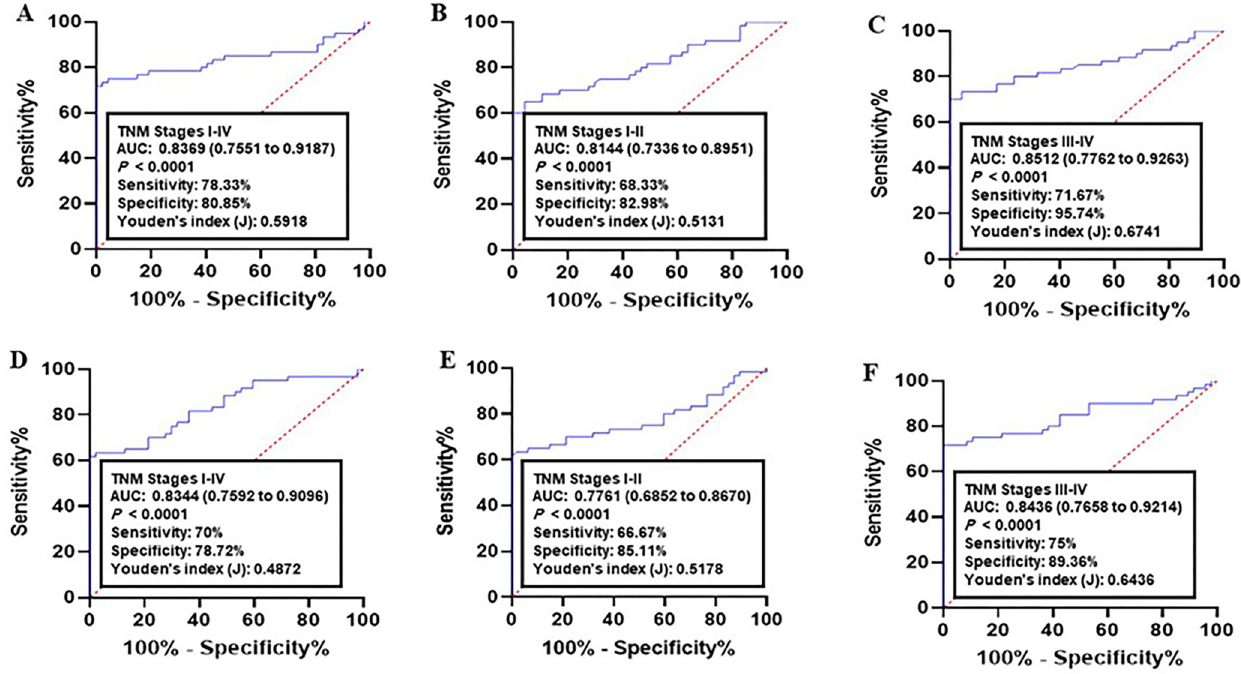
Fig 4. Receiver operating characteristics (ROC) curve analysis of the logit model with the CALU/AURKA/MCM2 panel. (A-C) The area under the ROC curve (AUC) assessment of the logit(p) value for the CALU/AURKA/MCM2 panel in distinguishing (A) colorectal cancer (CRC) patients (All TNM stages), (B) early CRC (I-II TNM stages), and (C) advanced CRC (III-IV TNM stages) from the healthy controls in training set. (D-F) The area under the ROC curve (AUC) assessment of the logit(p) value for the CALU/AURKA/MCM2 panel in distinguishing (D) CRC cases (All TNM stages), (E) early CRC (I-II TNM stages), and (F) advanced CRC (III-IV TNM stages) from the healthy controls in validation set. Logit(p) = 19.3608–0.2534 X (CALU)– 0.1822 X (AURKA)– 0.2016 X